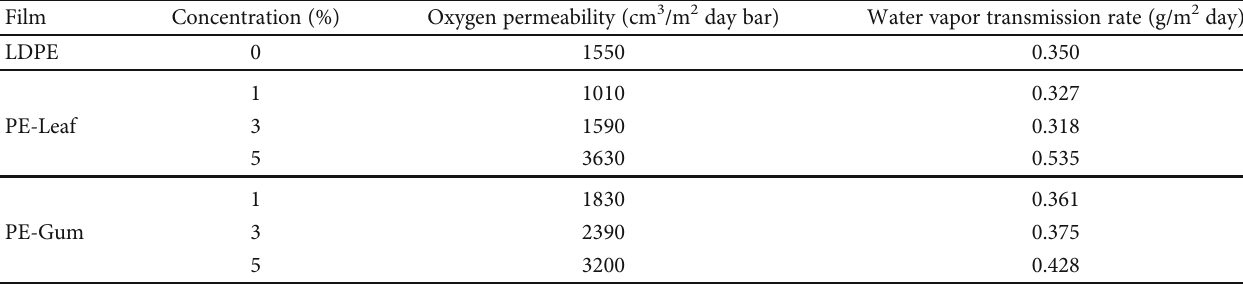
Table 5: Oxygen permeability and water vapor transmission rate of control and active fi